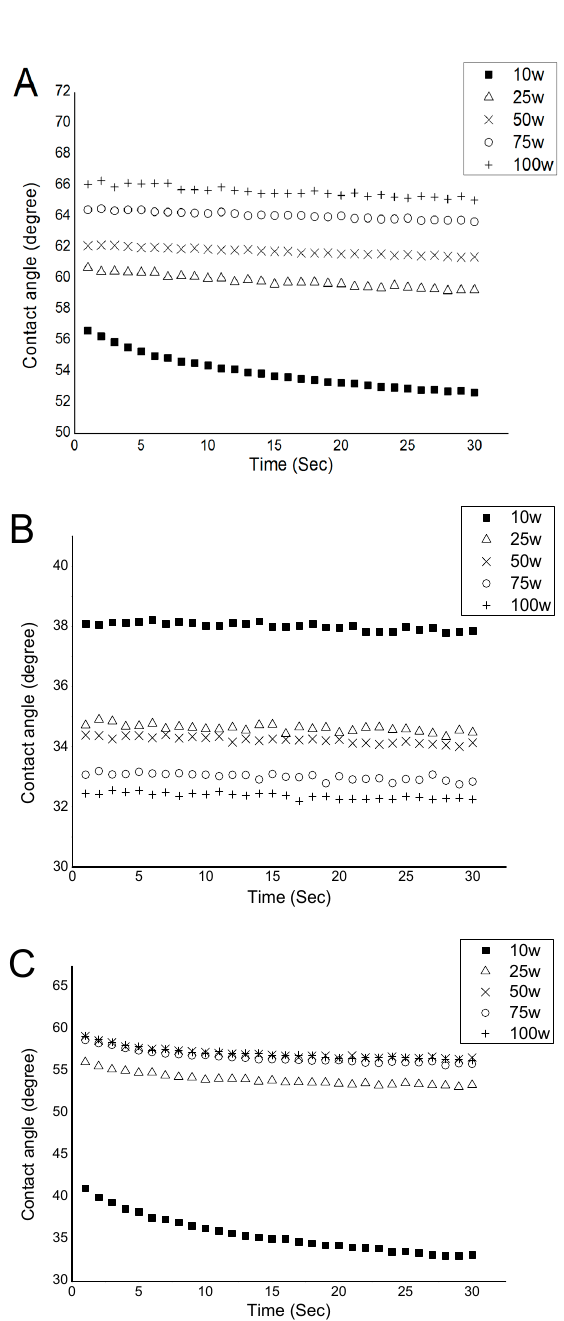
Figure 7. Evolution of contact angle with contact time: ( A ) water, ( B ) DIM, and ( C ) glycerol. Geranium oil-derived polymer films revealed contact angles ranging from ~50 ◦ to 60 ◦